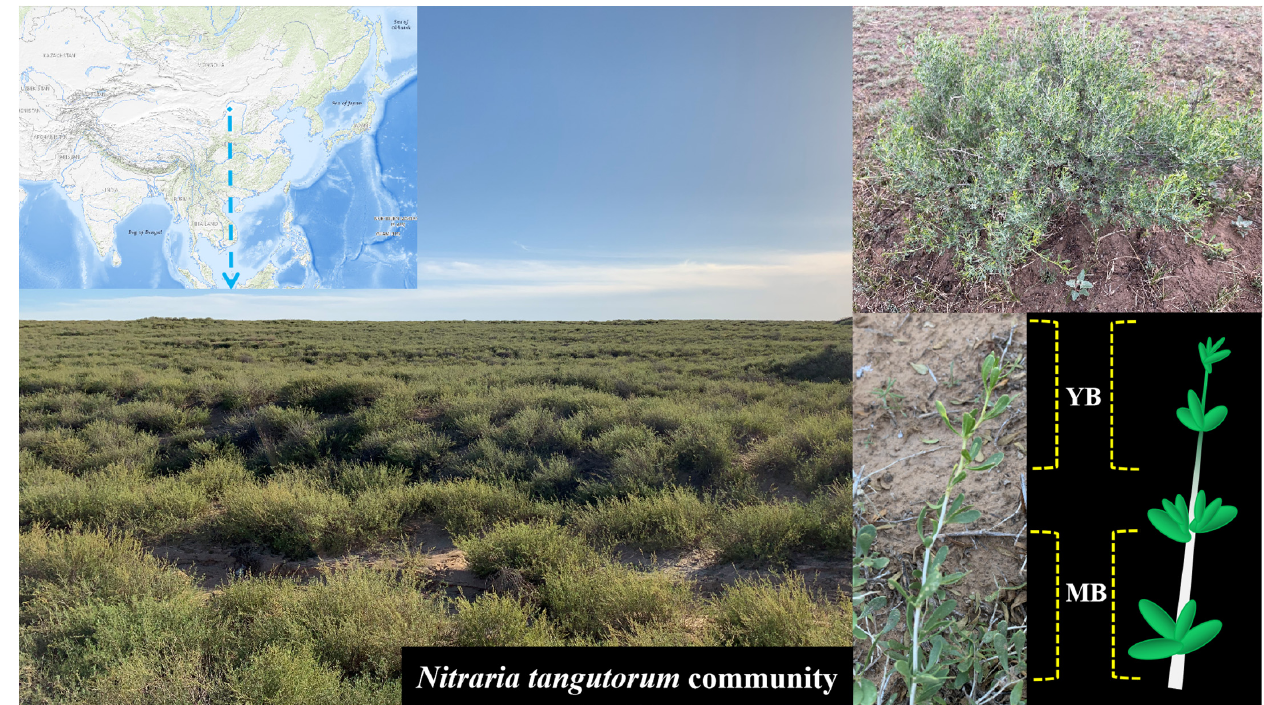
Figure 1. Sampling diagram of Nitraria tangutorum in Laba Lake Forest Farm in Northwestern China.